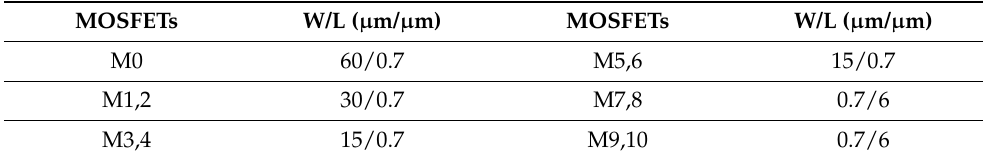
Table 1. Dimension of MOSFETs in a folded cascode op amp.